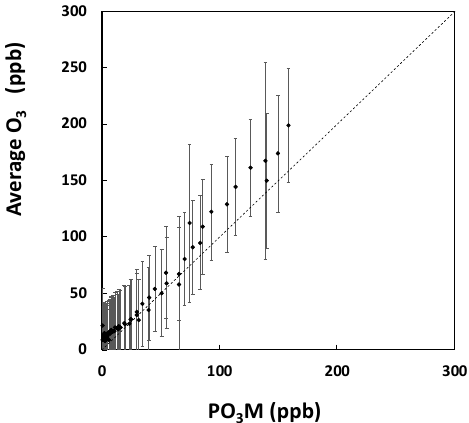
Figure 7. Decay test results for the average O 3 concentration for all sensors relative to the reference measurements from the Personal Ozone Monitor (PO 3 M). The error bars represent one standard deviation.